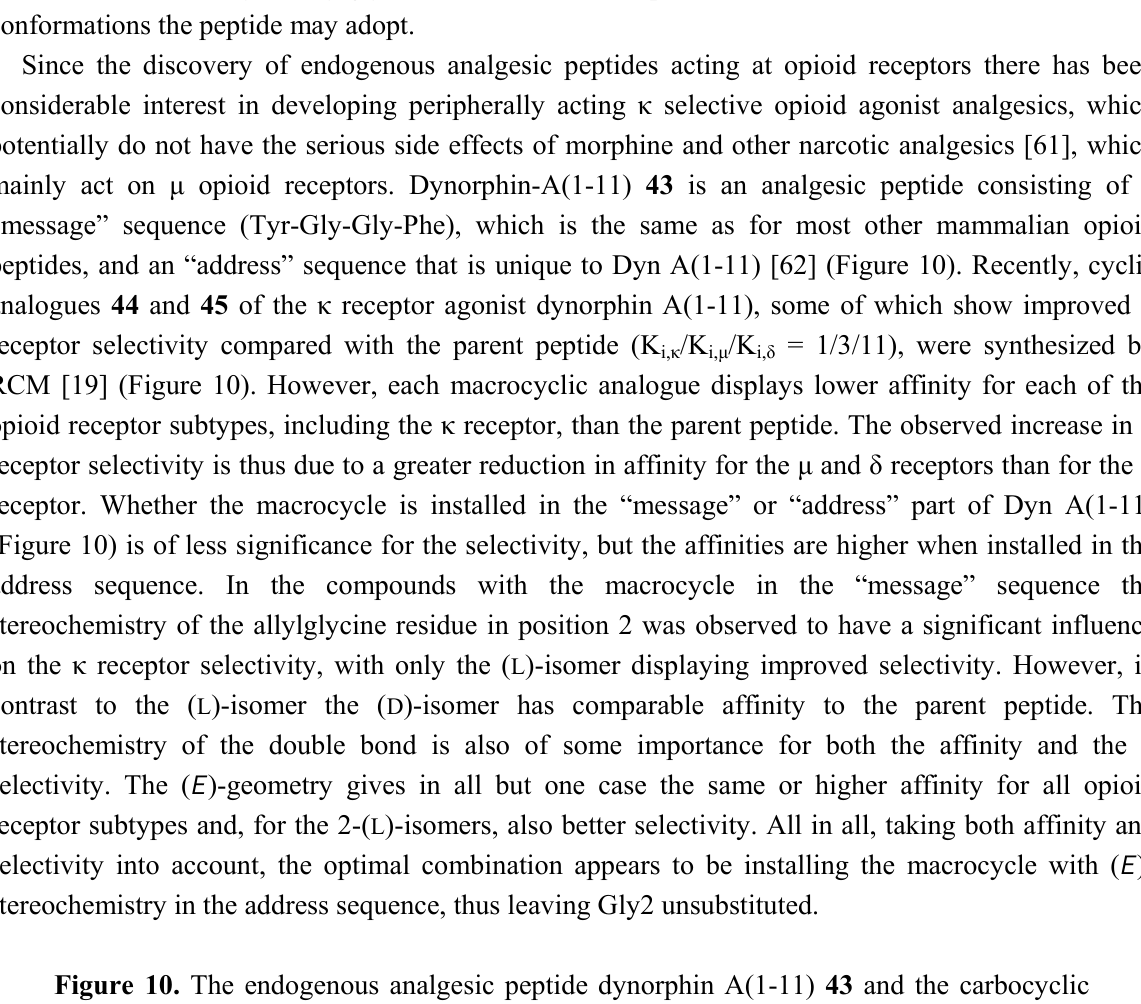
Figure 10. The endogenous analgesic peptide dynorphin A(1-11) 43 and the carbocyclic analogues 44 and 45 synthesized by